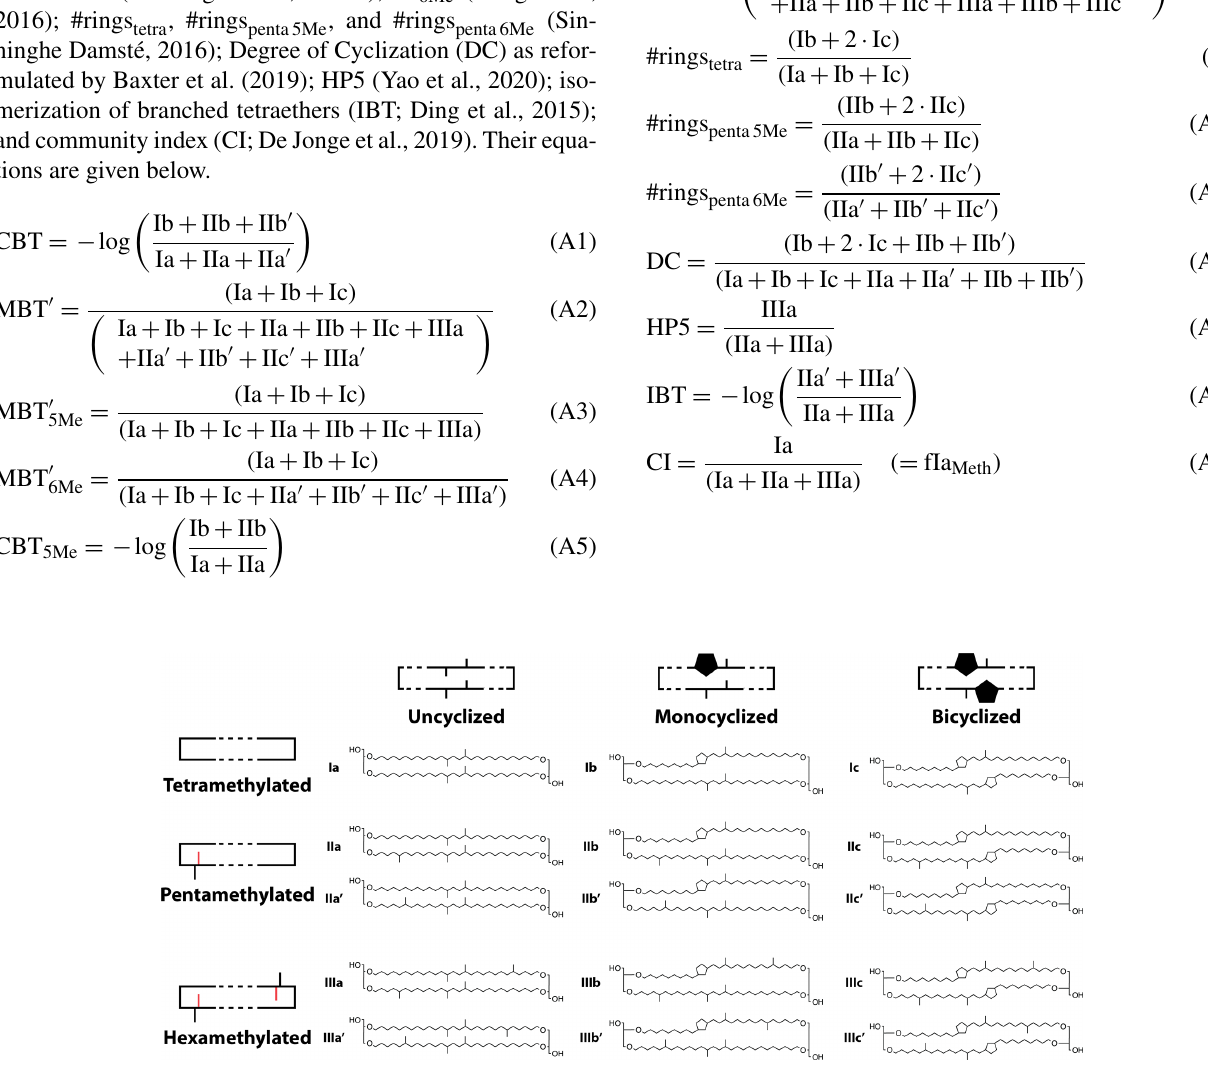
Figure A1. Structures of the 15 commonly measured brGDGTs along with their schematic representations, with C6 methylations denoted in red in the